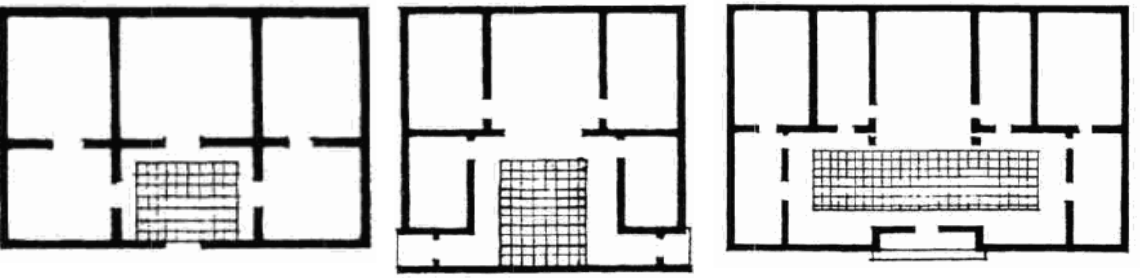
Figure. 3 The typical plans of Xiashanhu